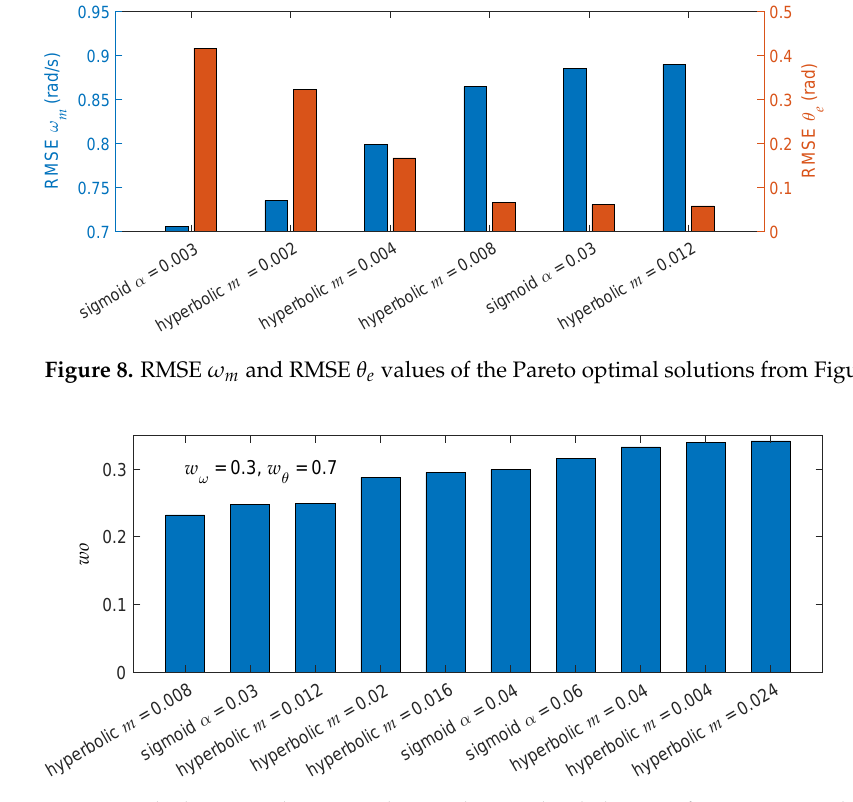
Figure 9. The best 10 values according to the weighted objective for w ω = 0.3 and w θ =